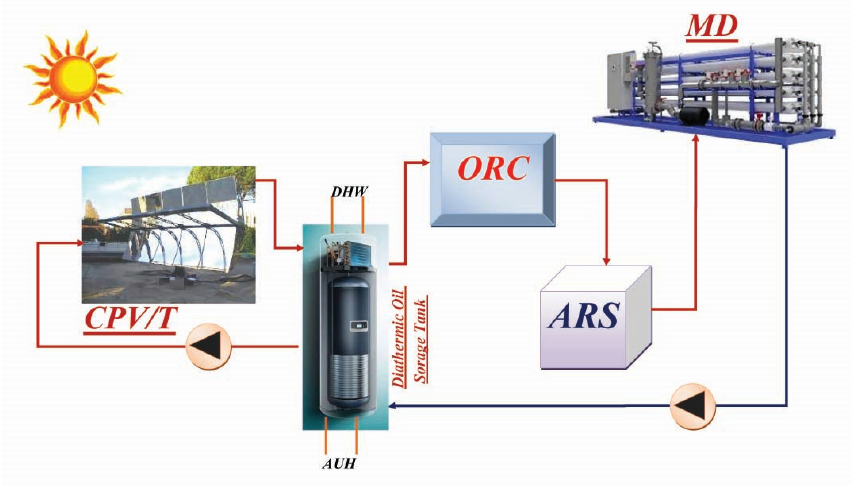
Figure 1. Schematic diagram of the proposed hybrid energy system.